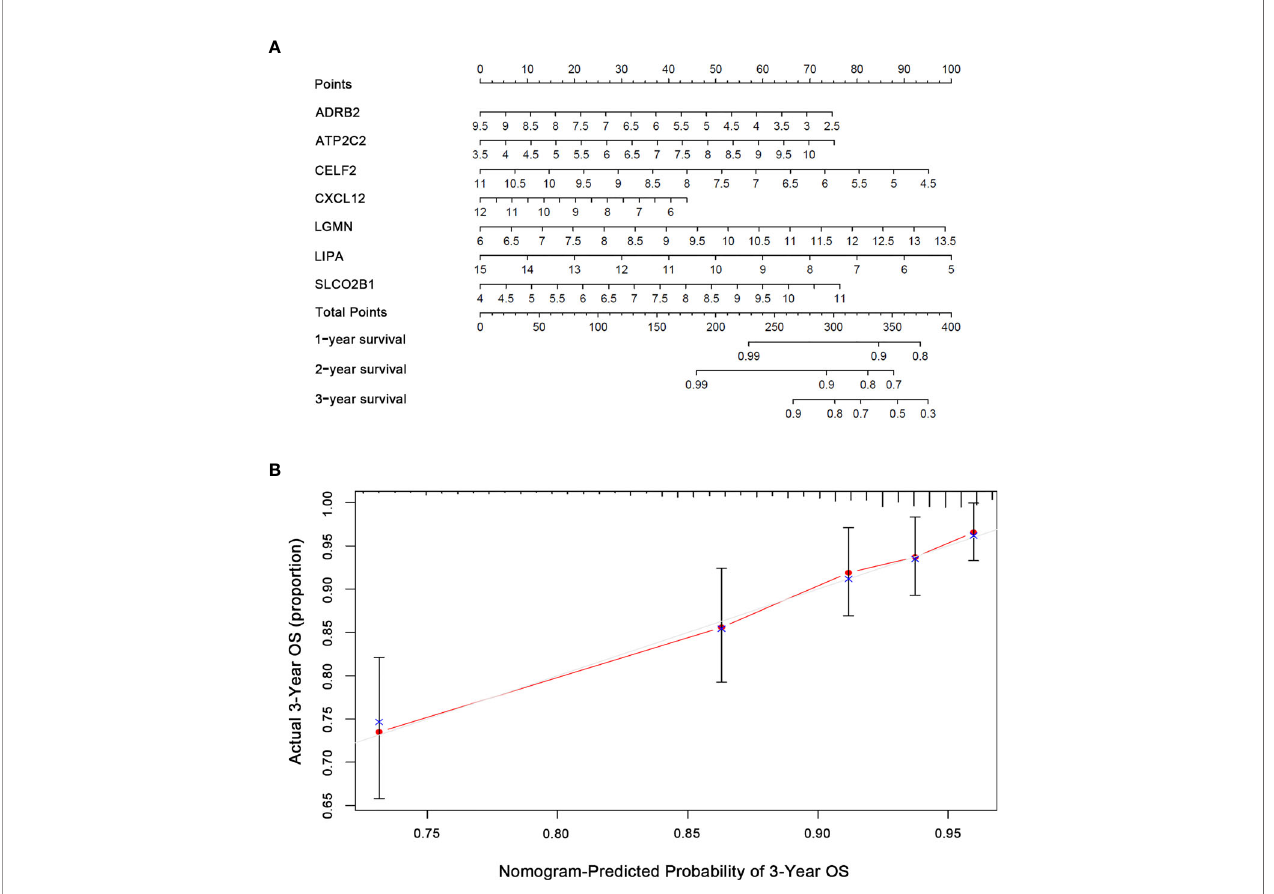
FIGURE 4 | Nomogram predicting OS for BRCA patients based on risk score. (A) Nomogram model for predicting the probability of 1-, 2-, and 3-year OS of BRCA. Points are assigned for seven features. The sum of these points is located on the total points axis. The total points on the bottom scales correspond to the predicted 1-, 2-, and 3-year survival. (B) Calibration plots of the nomogram for predicting the probability of OS at 1, 2, and 3 years. The X-axis represents nomogram- predicted survival, and the Y-axis represents actual